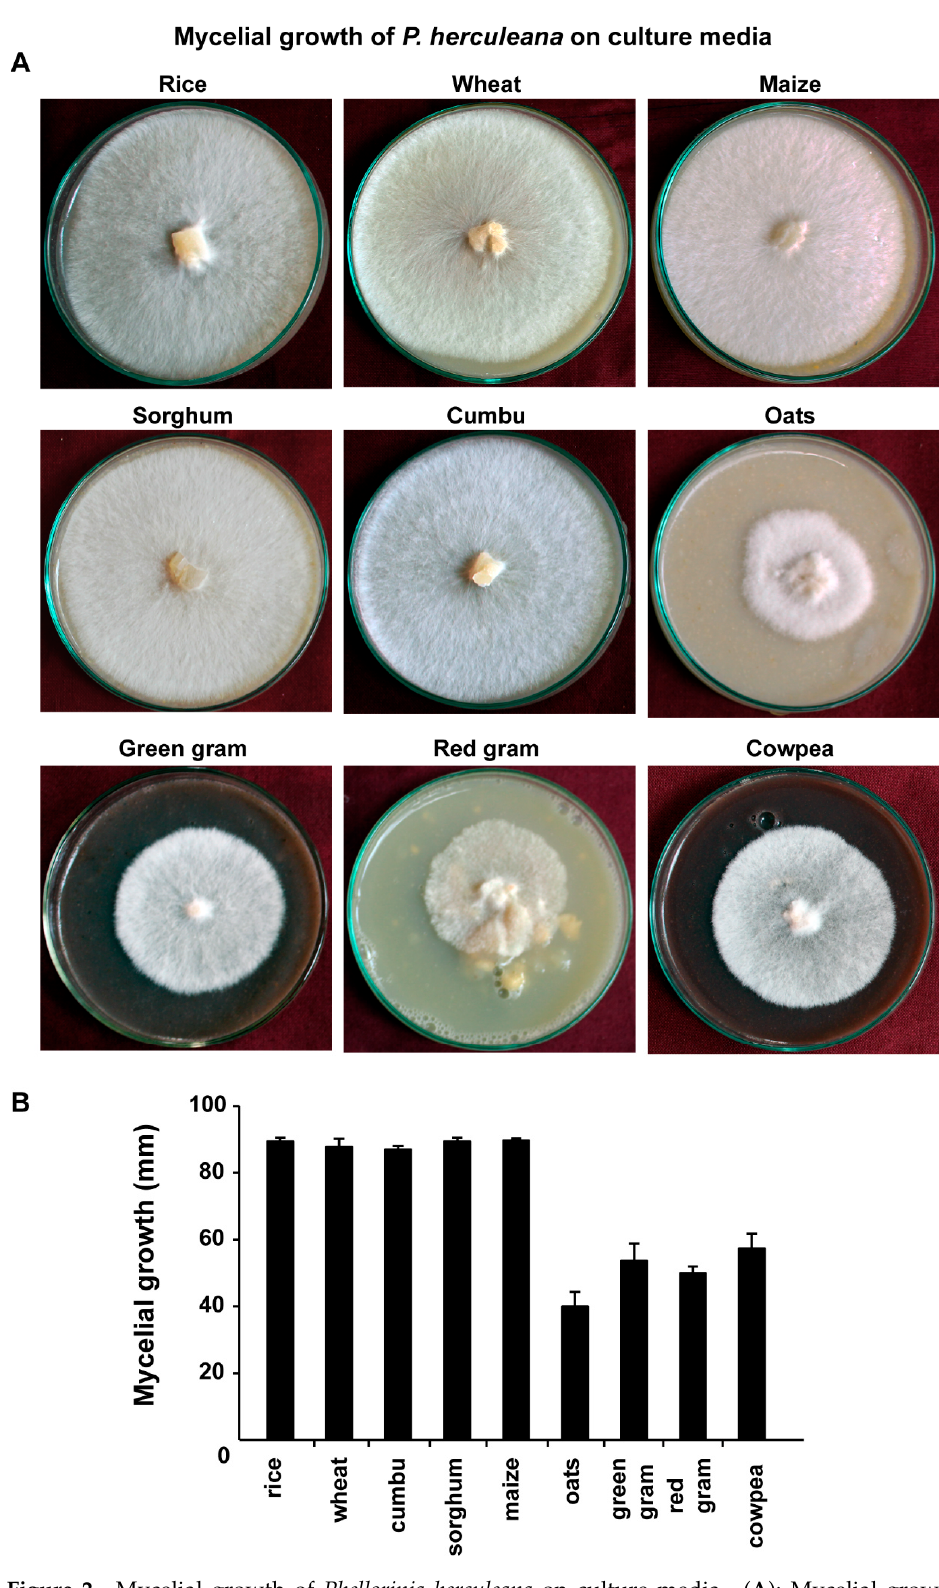
Figure 2. Mycelial growth of Phellorinia herculeana on culture media. ( A ): Mycelial growth of P. herculeana on cereal grain-based and pulse grain-based agar medium; ( B ): The radial growth of P. herculeana , grown on different culture media, was measured in millimeter. Error bar indicates the standard